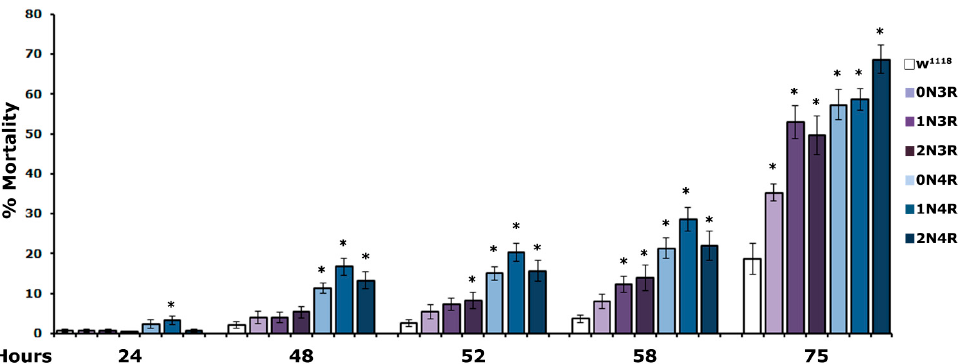
Figure 7. CNS accumulation of all hTau isoforms increases vulnerability to oxidative stress. The mortality of flies accumulating the indicated hTau isoforms and controls upon exposure to 5% H 2 O 2 at 25 °C scored at 24, 48, 52, 58 and 75 h is shown. The bars represent the mean ± SEM from two independent experiments with at least 300 flies assessed per genotype. Stars indicate significant differences from control flies. Statistical details in Supplemental Table S7. Int. J. Mol. Sci. 2022 , 23 , 12985